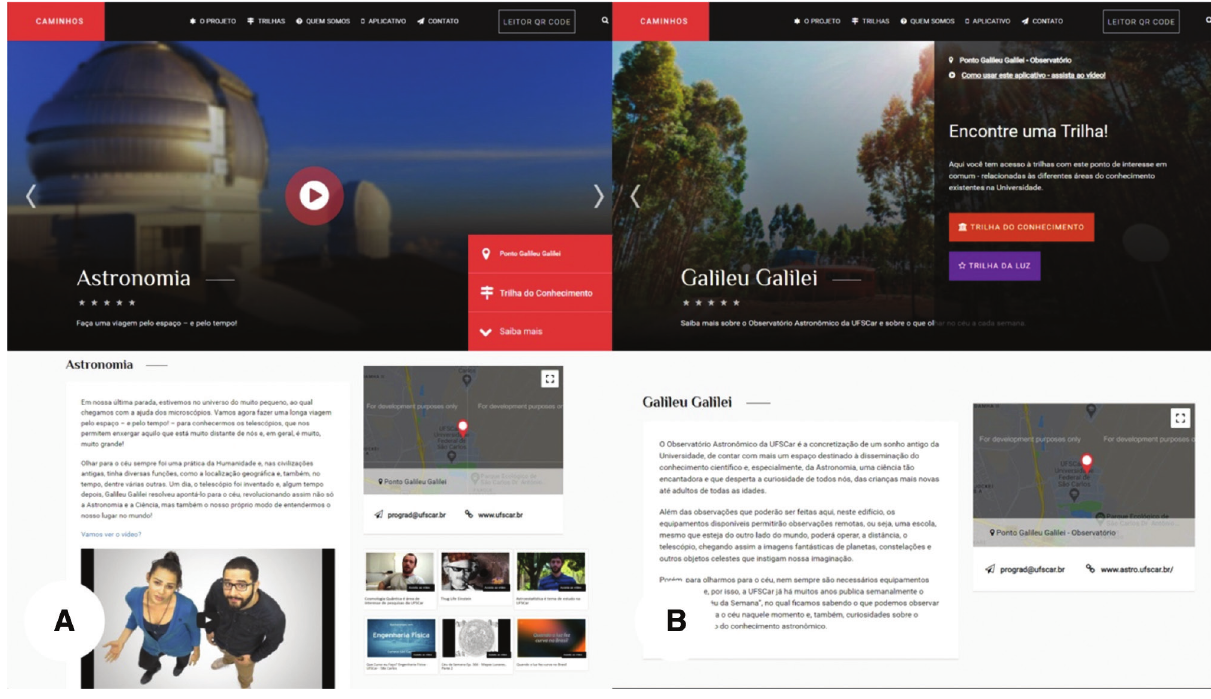
Figure 3. (A) Page with direct access to the specific video of the point of the trail chosen by the visitor (example: https://youtu.be/CZ4GPwo91os); (B) Page with text content and links to access additional content about the chosen point (example: https://www.caminhos.ufscar.br/places/ponto-galileu- galilei/) (Source: Authors,